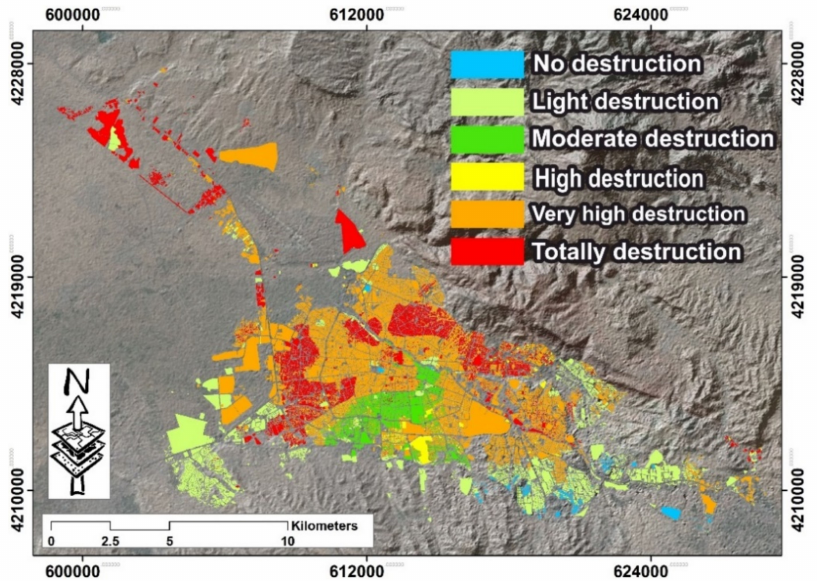
Figure 22. Extent of the destruction of structures for the 1721 earthquake with a magnitude of